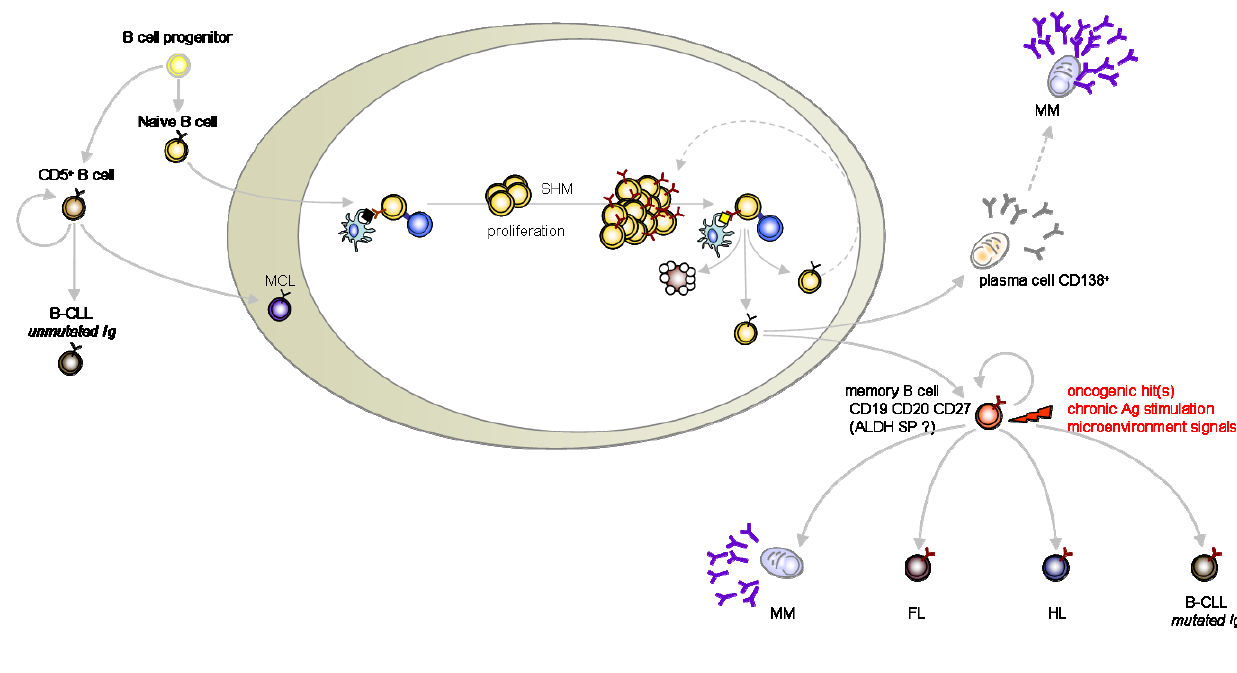
Figure 1. B-cell malignancies and their progenitor